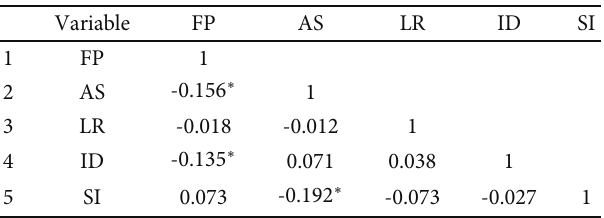
Table 4: Correlation matrix.